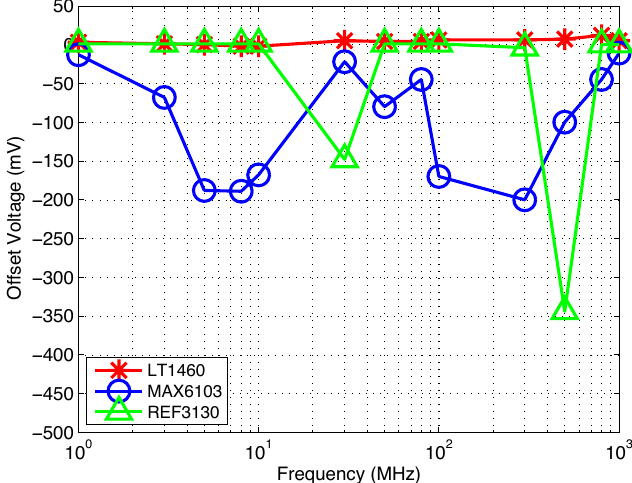
Figure 7. EMI induced offset in series voltage references: interferences coupled to the output pin.